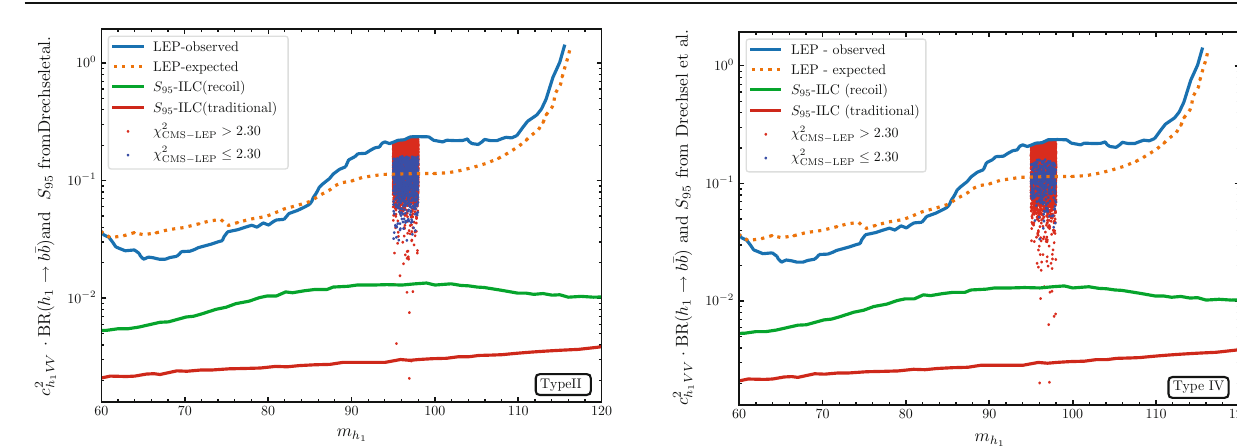
Fig. 14 The same as in Fig. 13, but with the points of our scan in the type IV scenario φ is the scalar being searched for. The LEP